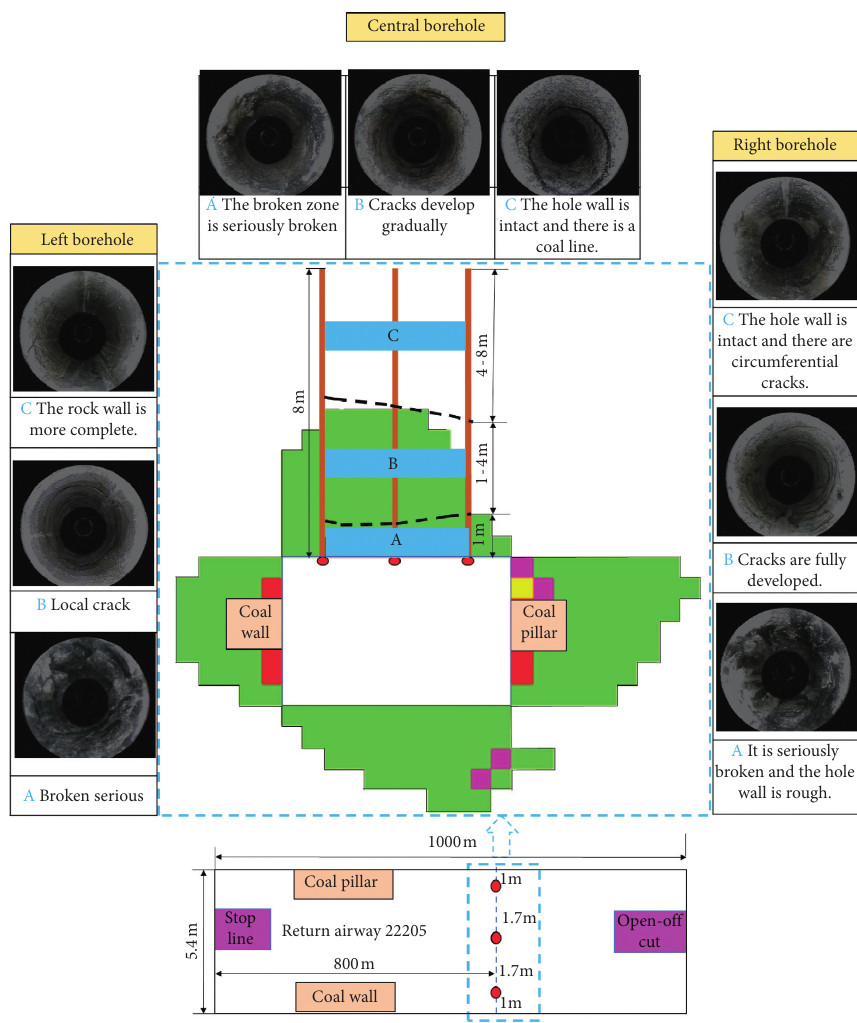
Figure 15: Layout scheme of borehole peep and the results of